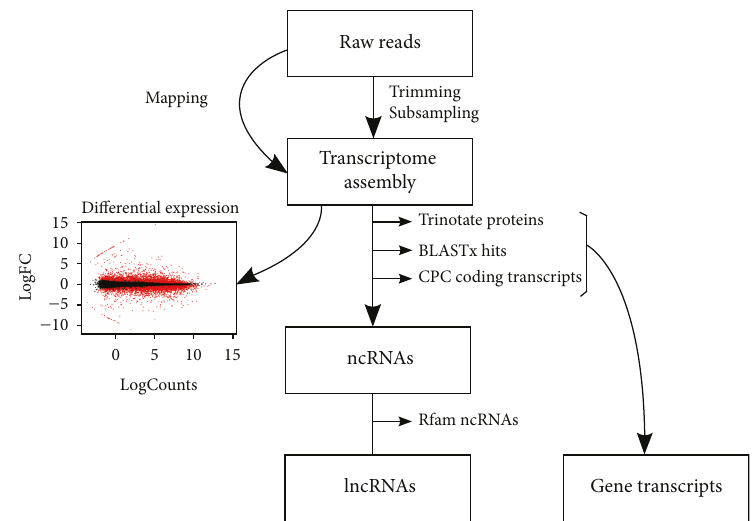
Figure 1: Pipeline of lncRNA